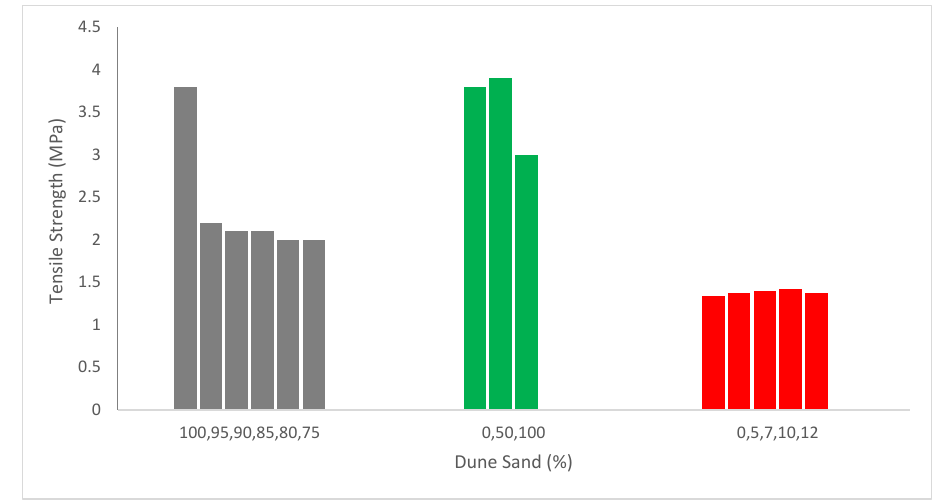
Figure 6. Tensile strength: data source [49,58,68].